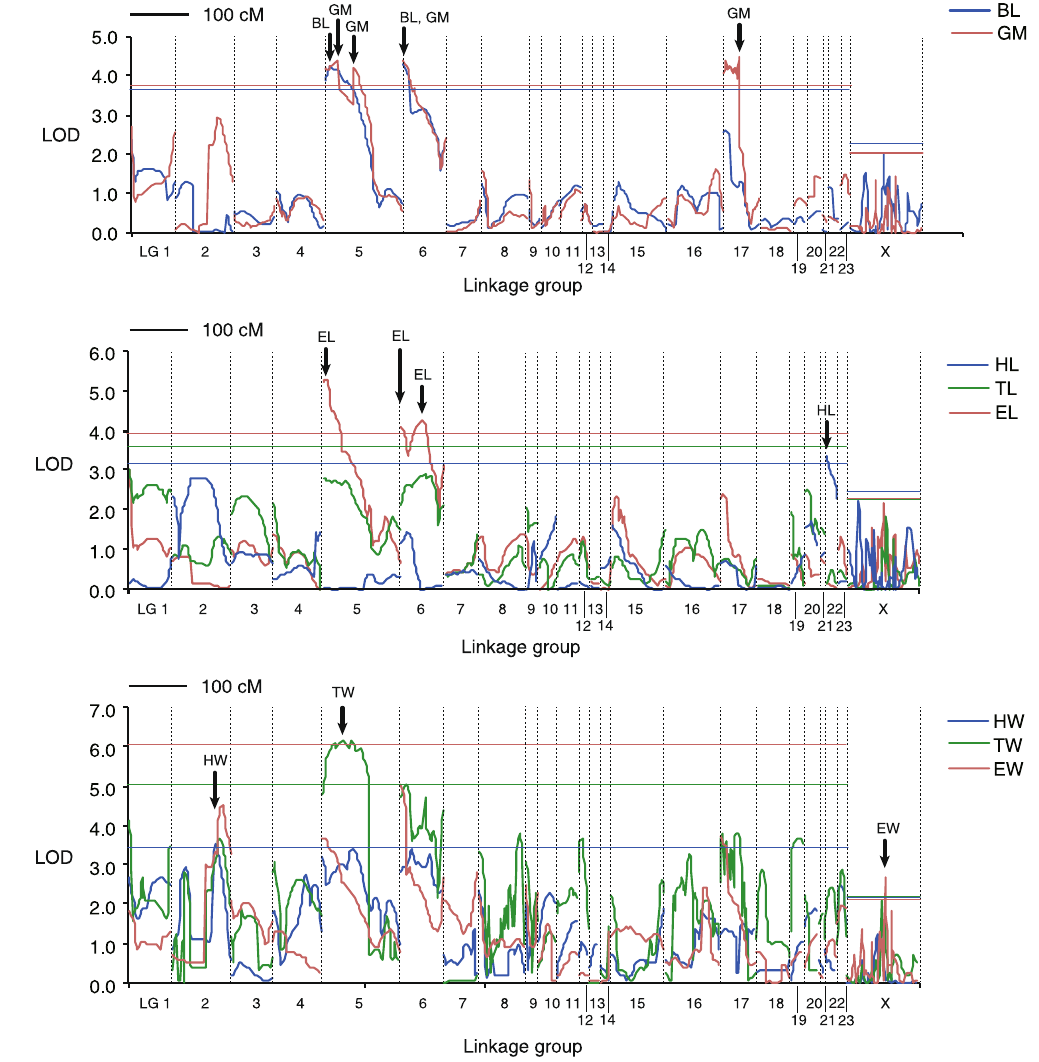
Figure 5. LOD scores for QTLs of body dimensions in the composite interval mapping analysis. Horizontal lines indicate threshold LOD values at α = 0.05. Arrows indicate peaks of LOD score.